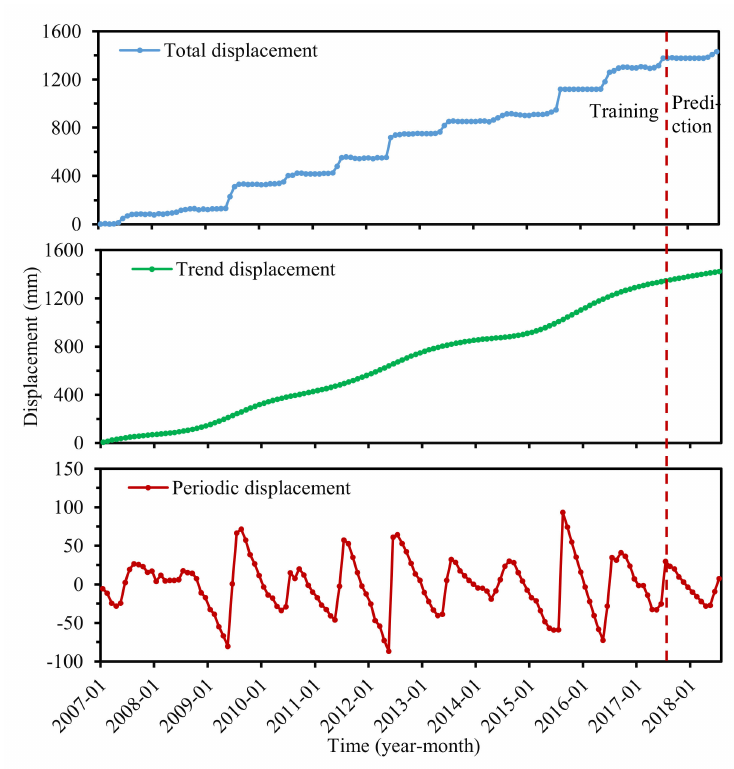
Figure 11. Displacement decomposition at